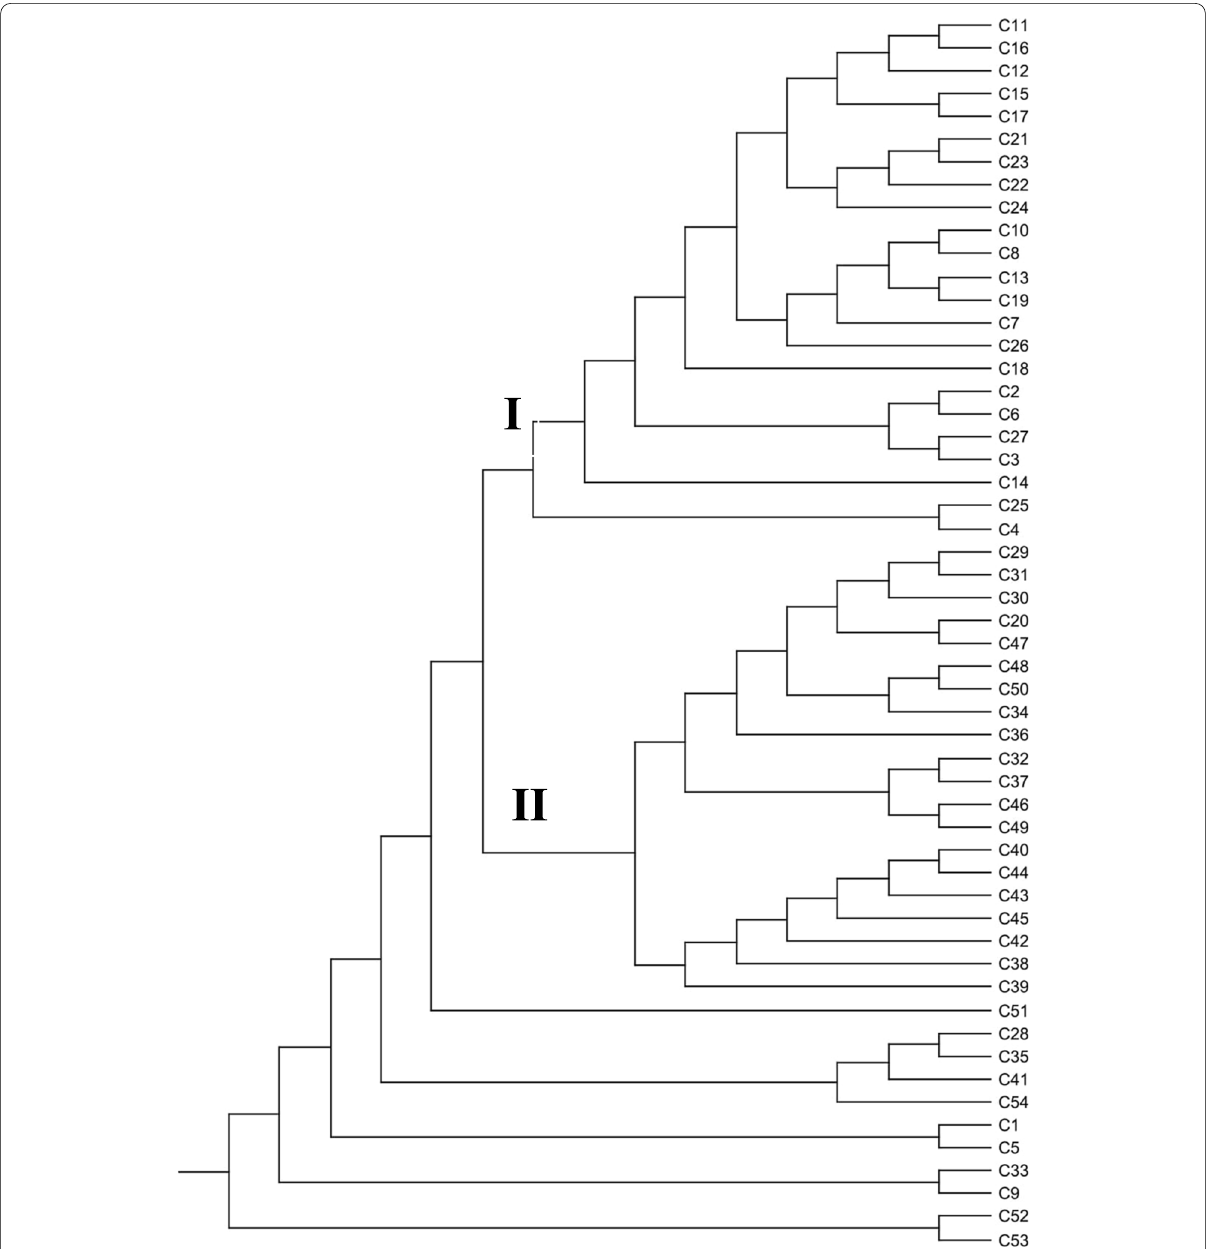
Fig. 5 UPGMA clustering analysis based on Jaccard’s similarity coefficient among 54 different chilli